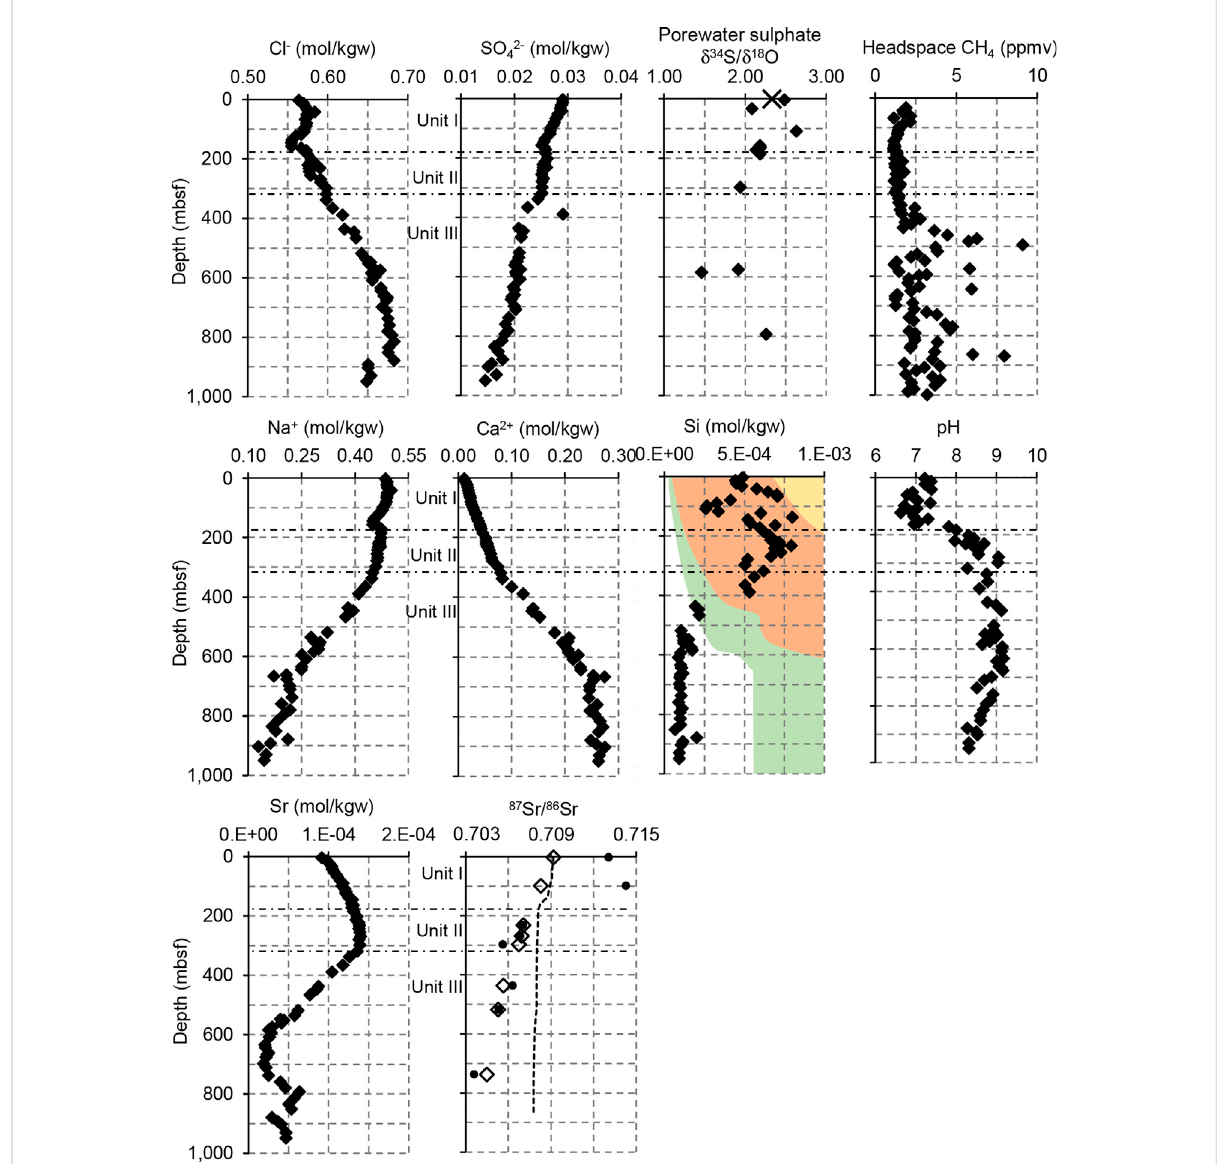
FIGURE 3 Observedporewaterdepthpro fi lesofchloride,sulphate,sulphate δ 34 Sand δ 18 Oratio(seawaterratioatsea-levelisshownwithacrossatthetop of the plot), headspace methane (CH 4 ), sodium, calcium, silica, pH, strontium; and, 87 Sr/ 86 Sr in porewater (open diamonds), bulk sediment (black dots), and contemporary global seawater (semi-vertical dashed line anchored at sea fl oor as ~ 0.709, calculated from McArthur et al., 2001). The stability fi elds of amorphous silica (yellow), α -cristobalite (orange), and quartz (green) calculated with PHREEQC are shown in the plot with observed porewater